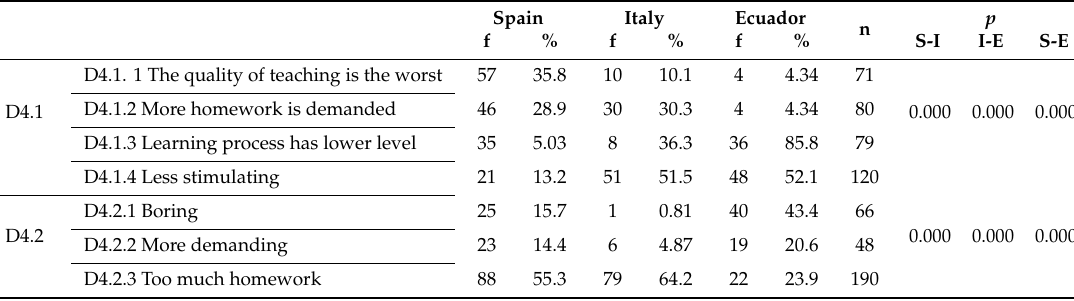
Table 5. Positive and negative aspects perceived by students among countries about teaching during the lockdown.